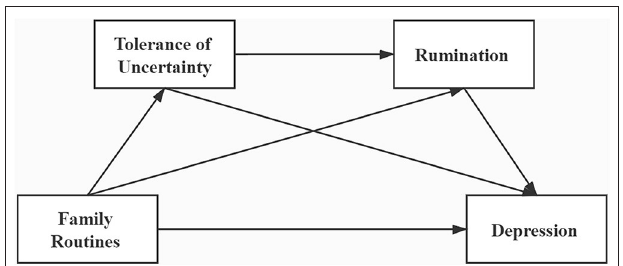
FIGURE 1 | Hypothesized